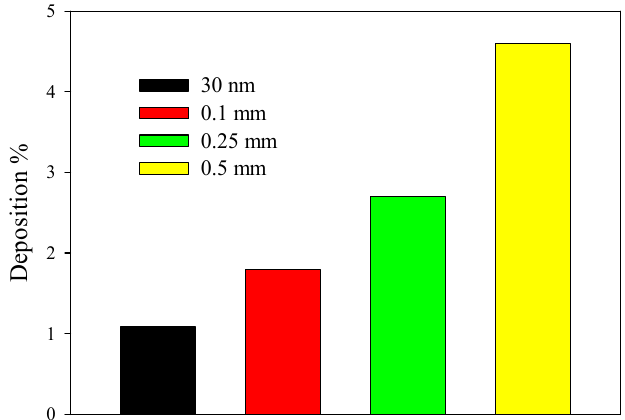
Figure 7. Particle deposition for different particle diameters at Re = 100, Φ = 0.01, and S/D = 1.5.